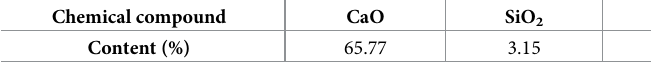
Table 2. Chemical composition of carbide slag. Chemical compound